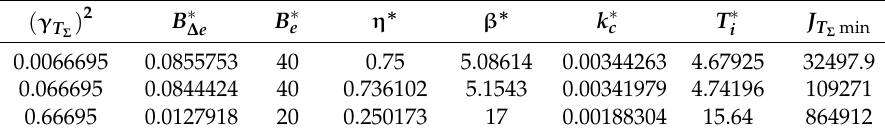
Table 2. Weighting parameter and controller parameters for the minimization of J T